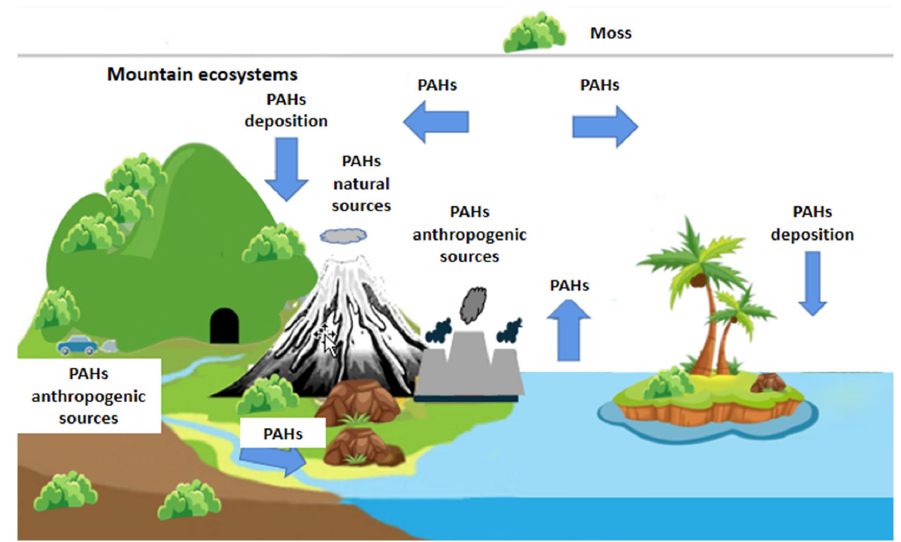
Figure 3. Moss biomonitoring system (created by author).